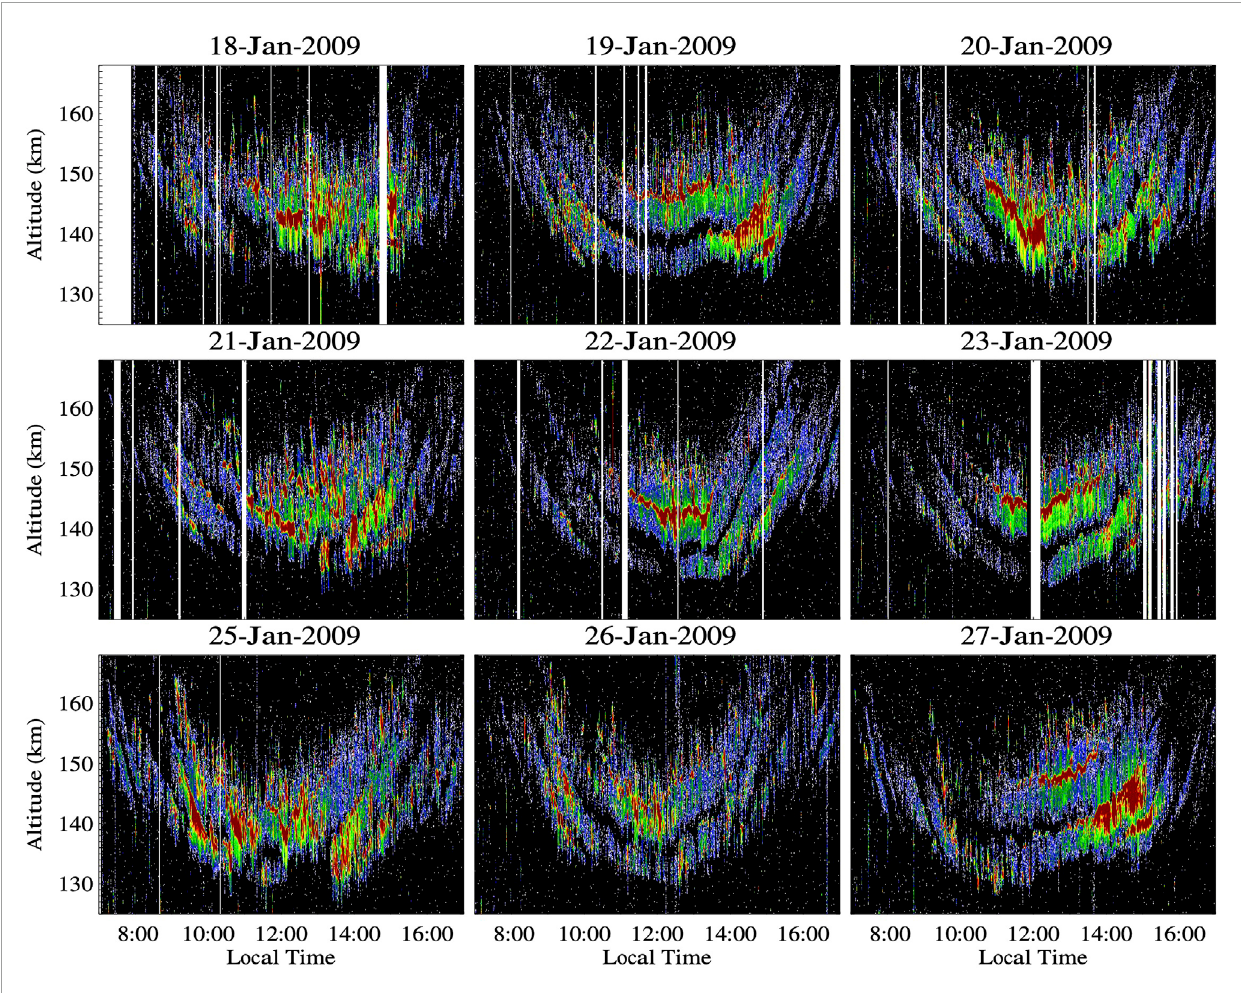
FIGURE 2 Altitude-time SNR observations of 150-km echoes over nine consecutive days in January 2009 over Jicamarca. The color scale is in dB. Very strong echoes (in red) present usually narrow features resembling layers (either ascending or descending) (from Chau and Kudeki, 2013, Figure 2).